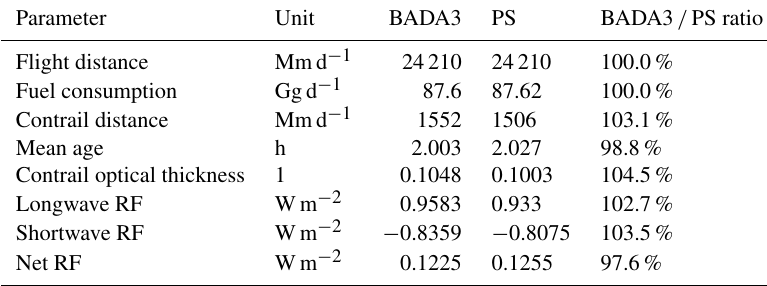
Table 5. Sensitivity to the performance models (July 2020).